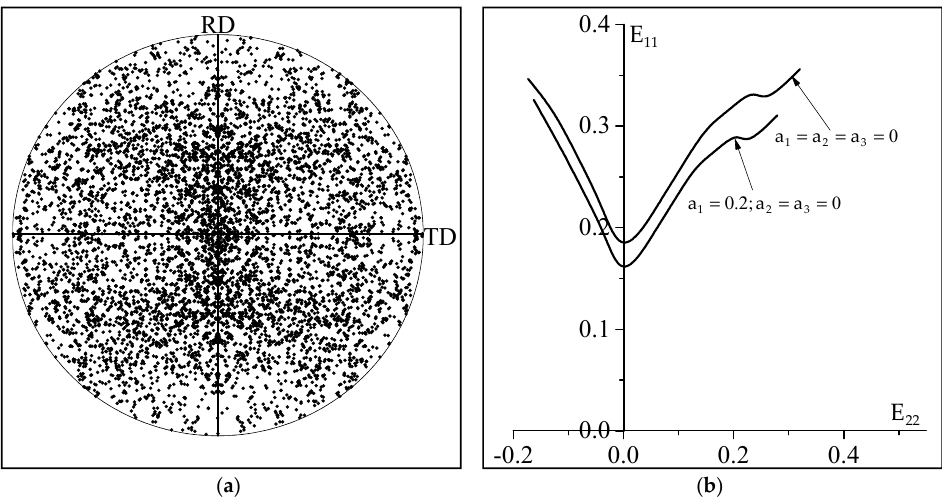
Figure 7. ( a ) Initial crystallographic texture ({111} pole figure); ( b ) Predicted forming limit diagrams.